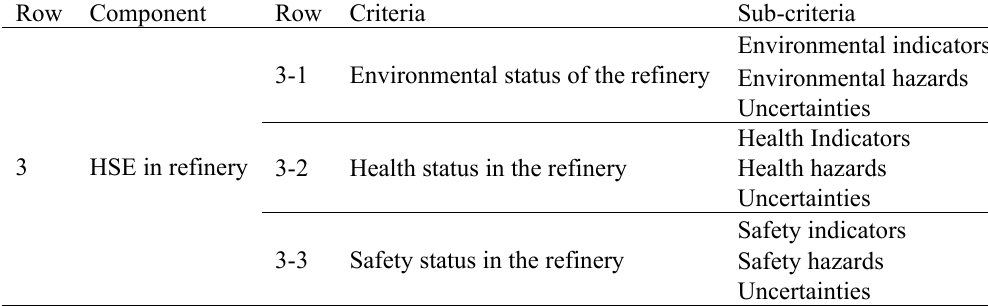
Table 3. Strategic components and criteria for HSE in refinery